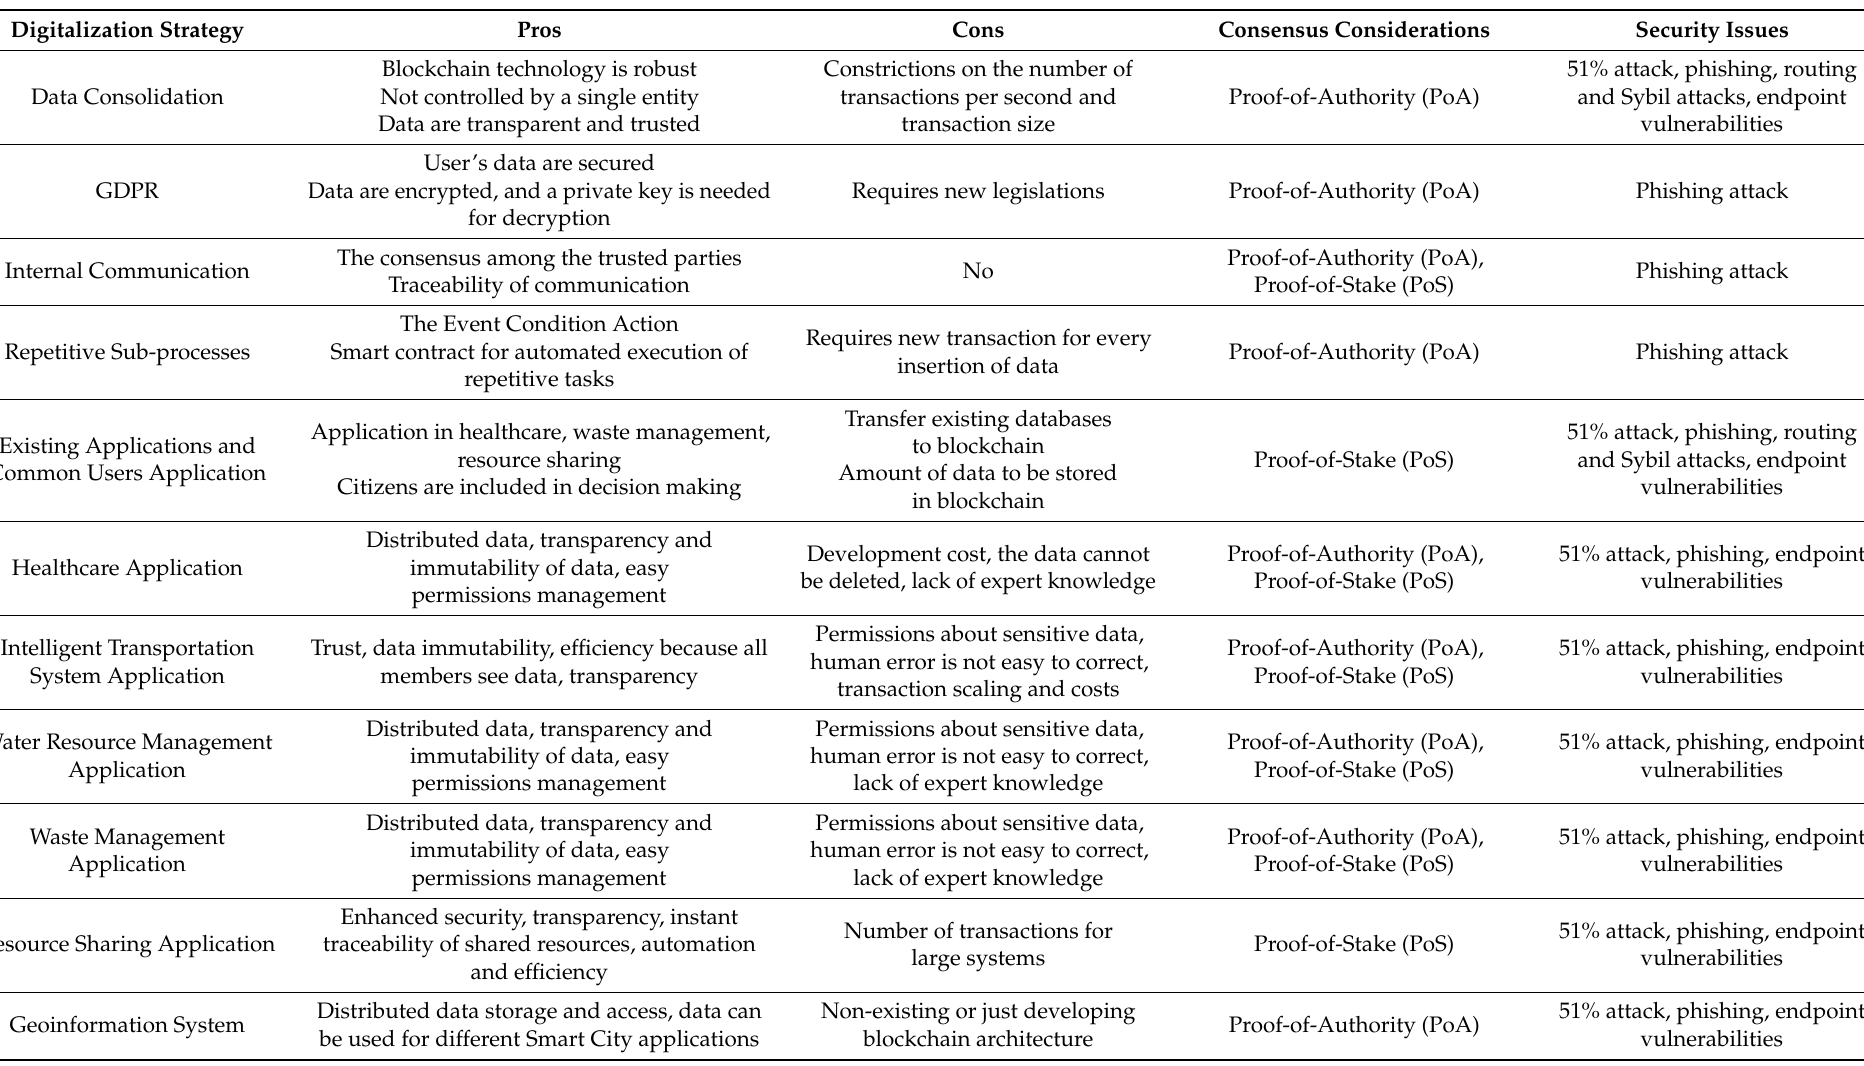
Table 3. Blockchain pros and cons for digitalization